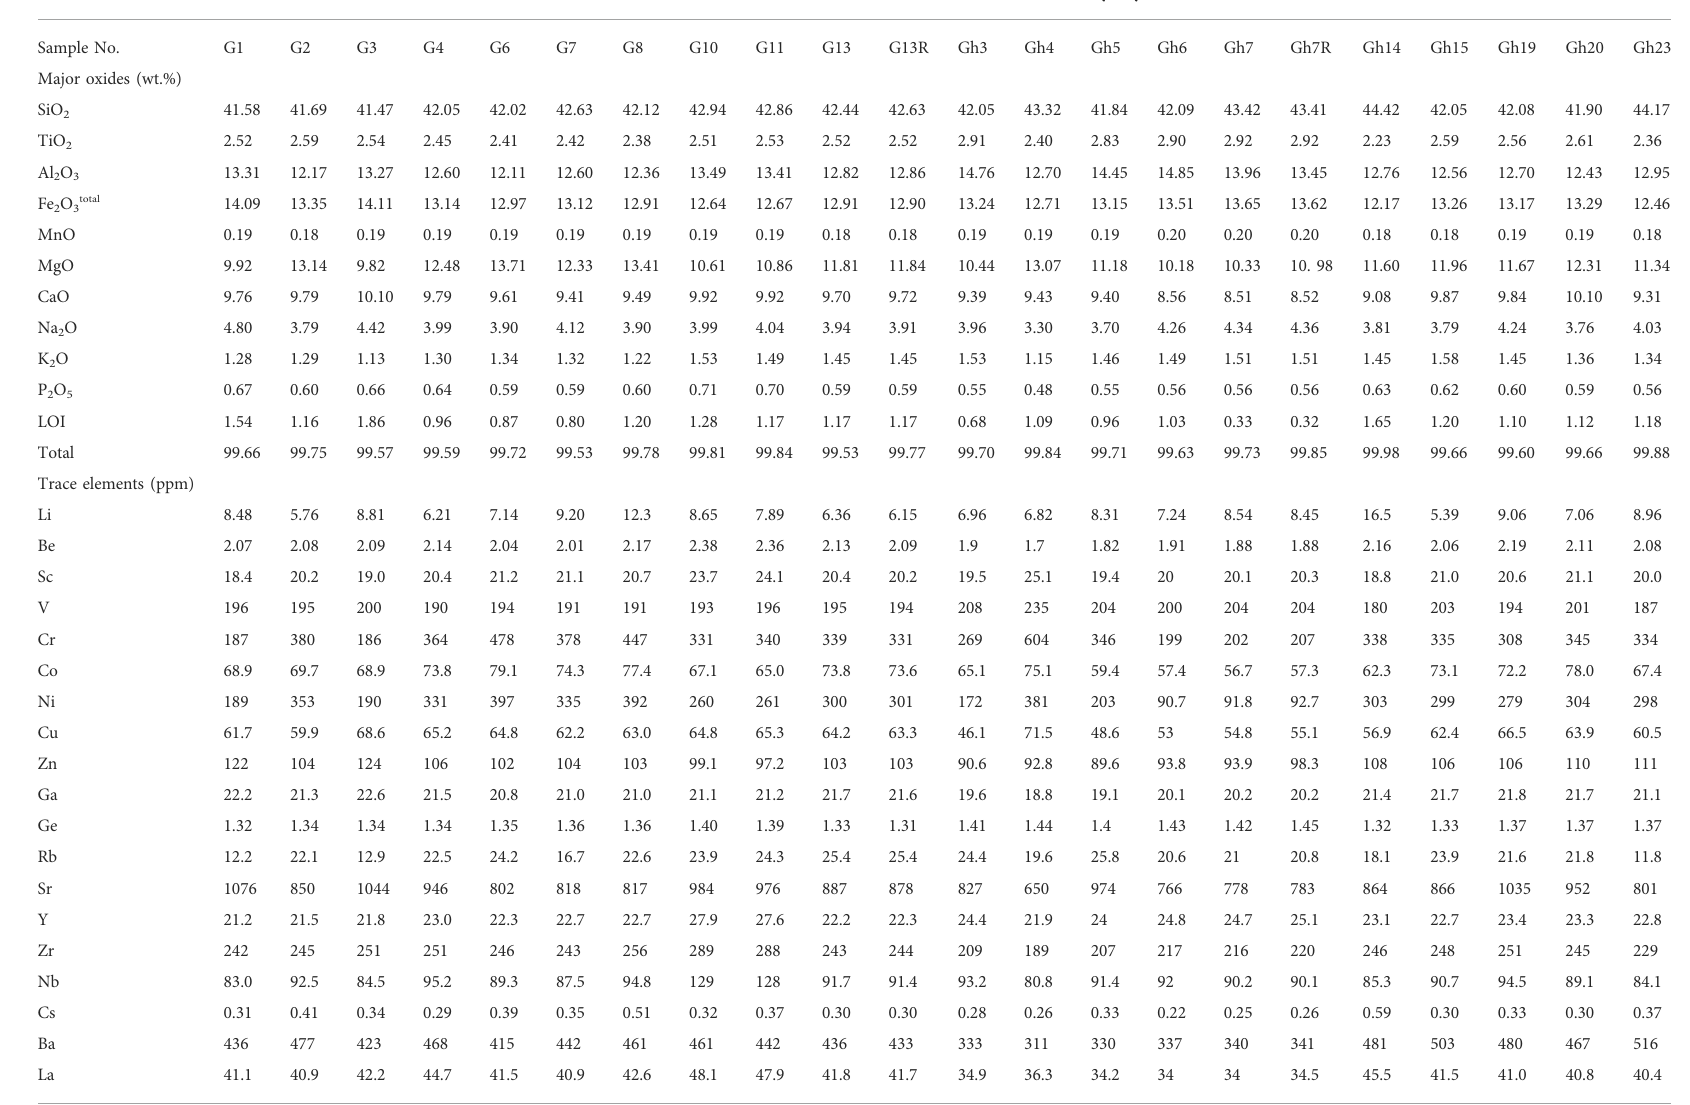
TABLE 1 Bulk-rock geochemical analyses. Area